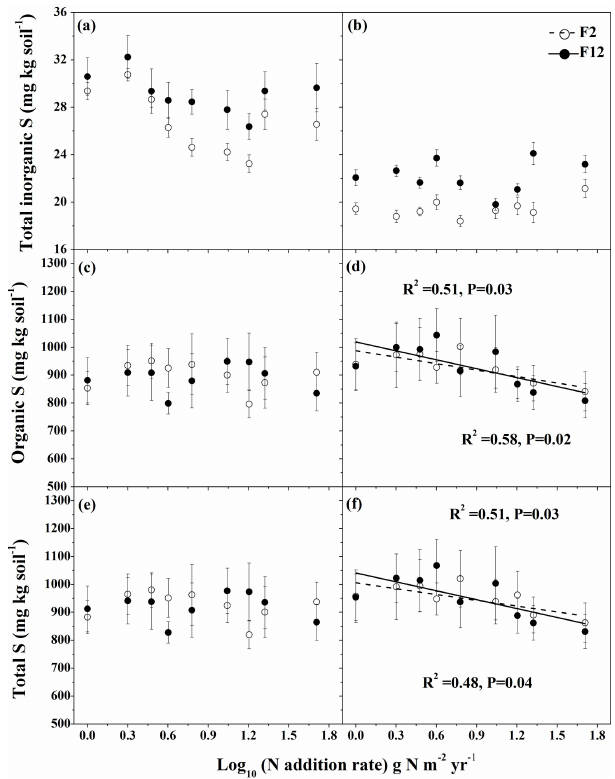
Figure 4. Effects of N addition intensity and frequency on concen- trations of soil total inorganic S (a, b) , organic S (c, d) , and total S (e, f) in unmown (a, c, e) and mown (b, d, f) plots. Dashed and solid regression lines correspond to 2 and 12N additions per year, respectively. Error bars indicate standard errors.